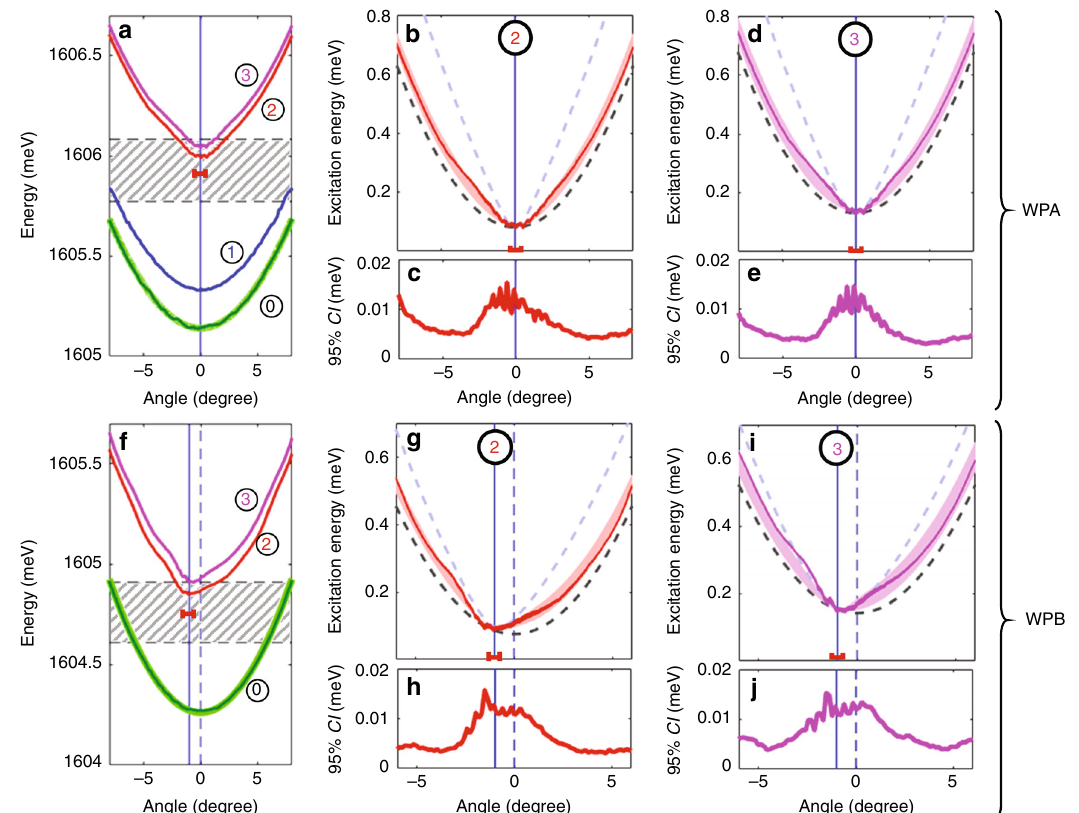
Fig. 3 Excitation dispersion relations. Measured DR _ ω ð θ Þ as obtained from the numerical analysis of the EPL (solid colored lines) for WPA ( a ) and WPB ( f ). Four states of the fl uids are shown according to their position along I 0 ð P Þ (plotted in Fig. 2a for WPA): “ 0 ” is the free-particle DR (green line), “ 1 ” is a lower branch state of I 0 ð P Þ (blue), “ 2 ” and “ 3 ” are two upper branch states (red and magenta). The calculated free polariton DR is the thick light green line underneath the measured one. b , d and g , i are zoomed in plots of DR “ 2 ” (narrow red line) and “ 3 ” (narrow magenta line) of WPA and WPB, respectively, ¼ _ ω (cid:3) _ ω in units of condensate excitation energy _ ω . The 95 % con fi dence interval amplitude (CI) of the measured DRs is shown for each DRs in panels e l c , h and e , j for WPA and WPB, respectively, with the same color codes. The theoretical DRs in the rigid blueshift limit (dashed black line) and in the GGPE limit (blue dashed line) are shown in b , d , g , and i . The full vectorial theory is also shown as a thick red and magenta lines visible underneath the measured DR; the line thickness represents the 95% con fi dence interval of the fi tting procedure with the data. In each panels, the laser energy and angular spread are shown as a red segment, and the vertical blue line shows the angle of excitation. The hatched rectangle is the spectral range rejected by the notch fi lter in a and